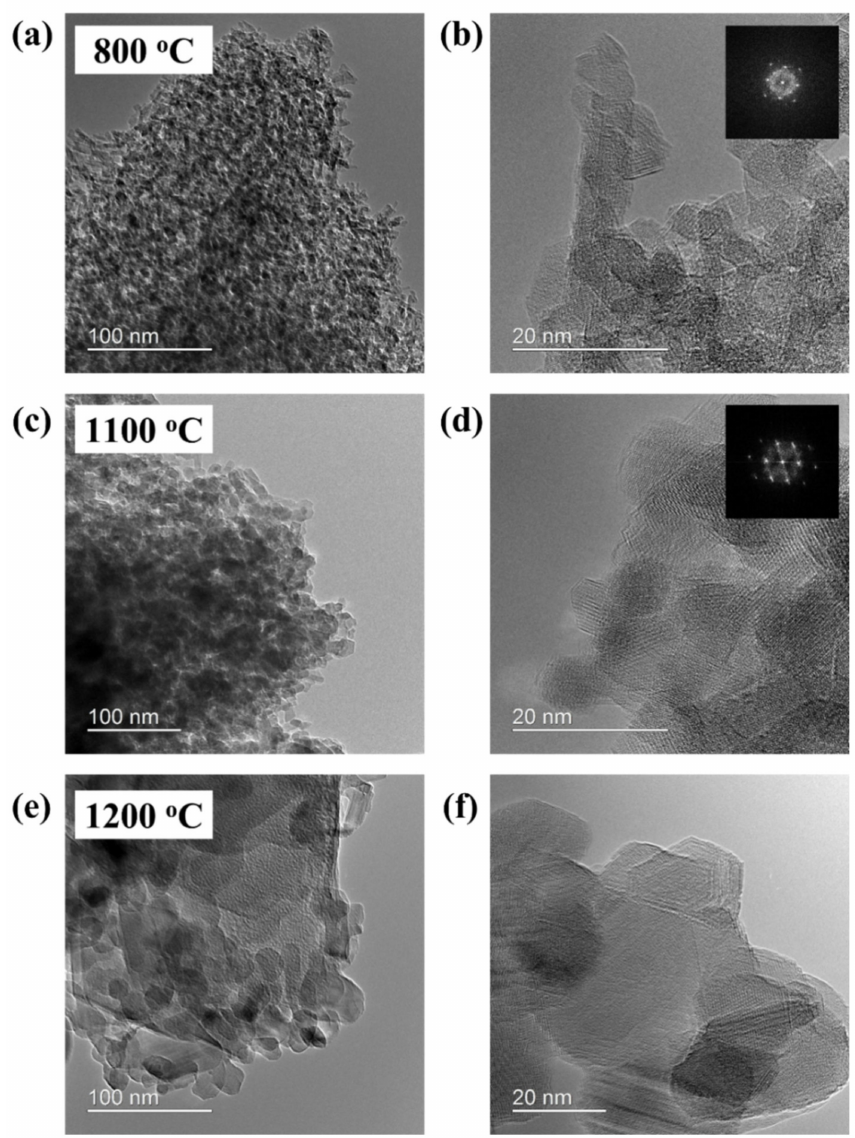
Figure 8. TEM images of the Al 2 O 3 ultrafiltration (UF) membranes; ( a , b ) γ -Al 2 O 3 membrane sintered at 800 ◦ C, ( c , d ) α -Al 2 O 3 membrane sintered at 1100 ◦ C. ( e , f ) α -Al 2 O 3 membrane with sudden grain growth sintered at 1200 ◦